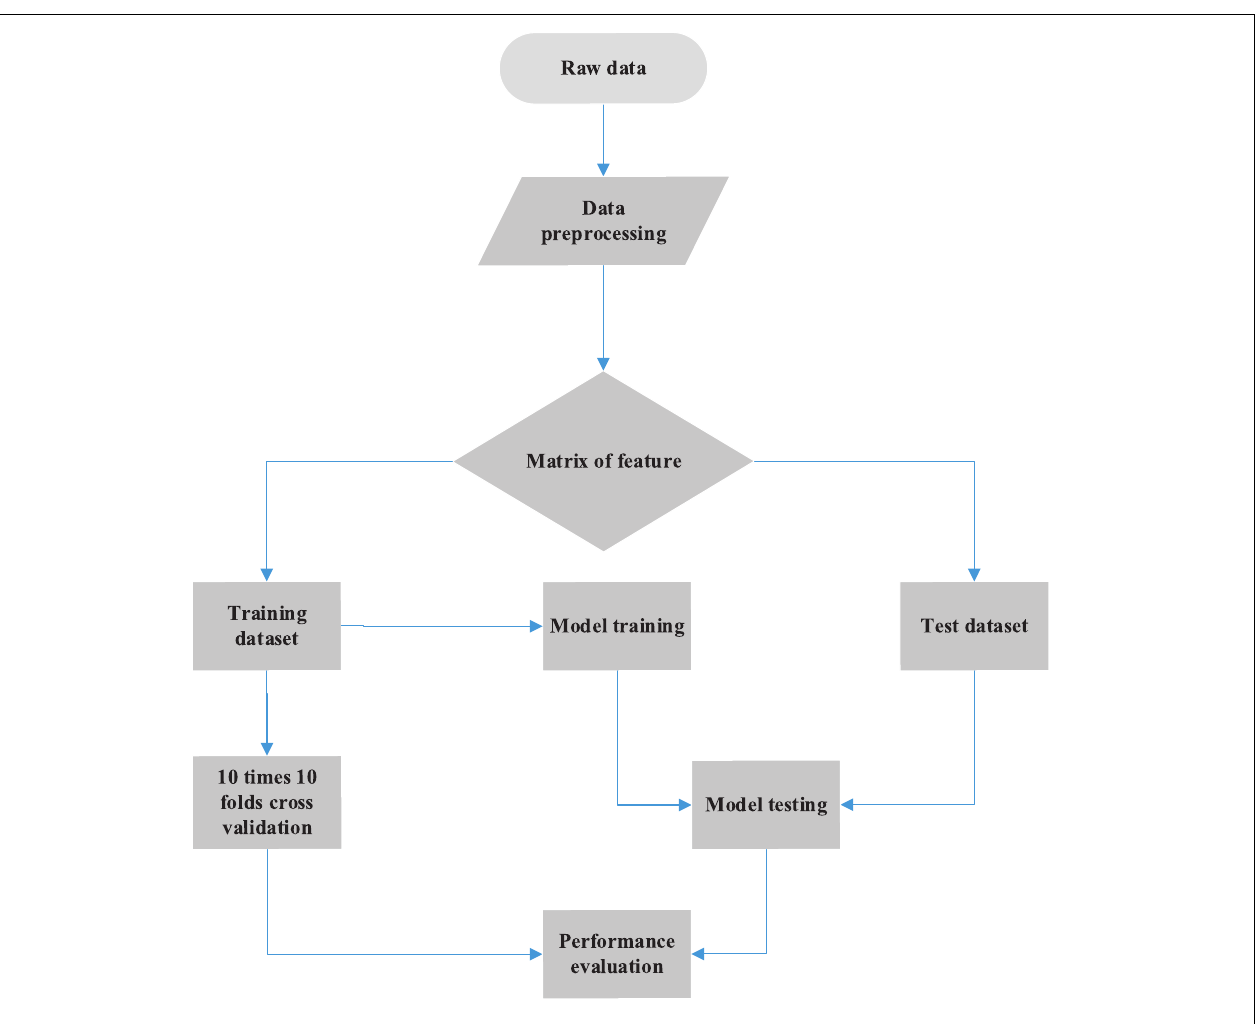
FIGURE 1 | Workflow of cancer tissue origin identification using somatic mutation